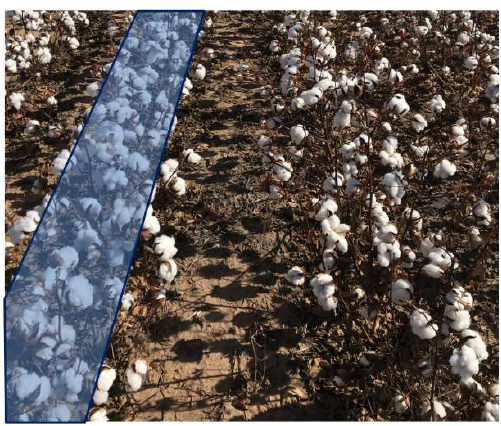
Figure 12. Ground photo of cotton plants and nadir view perspective.